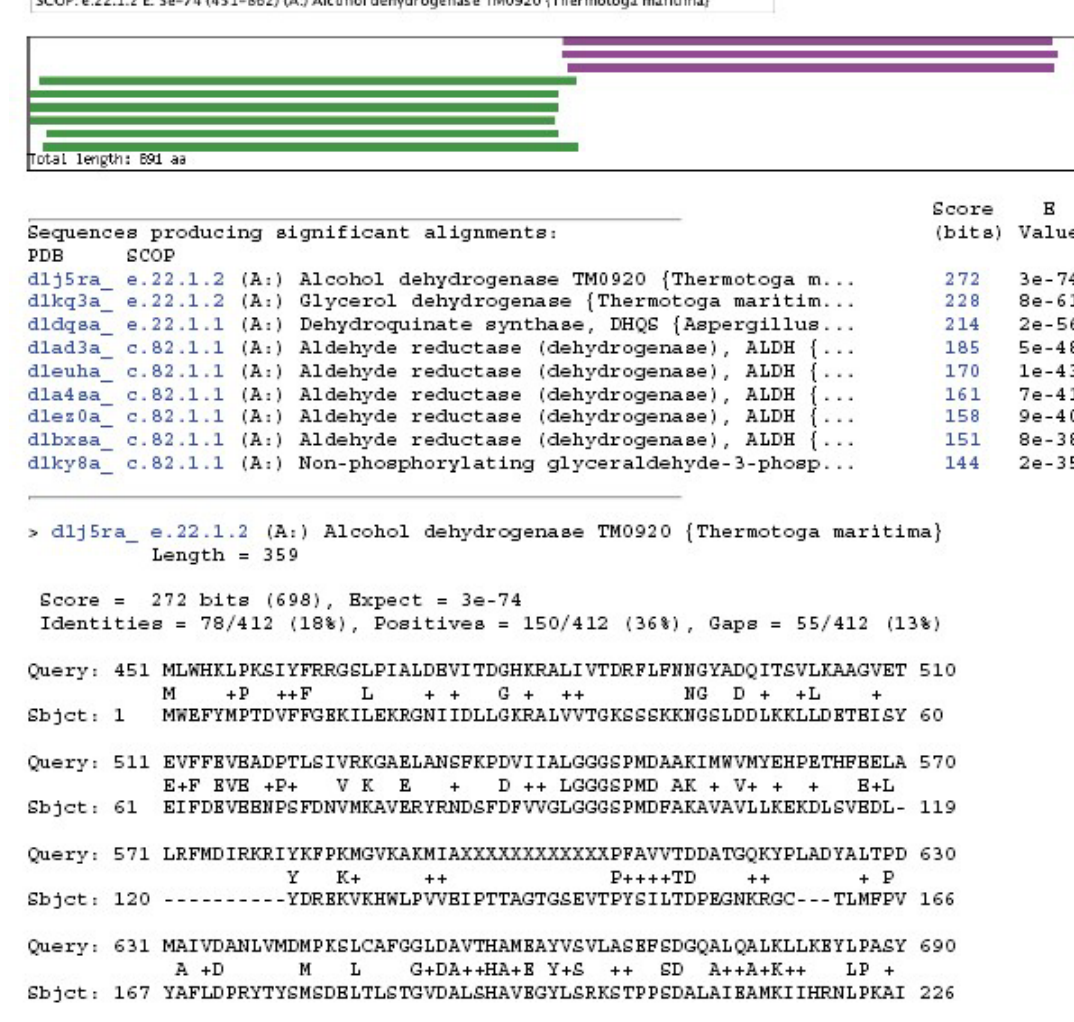
Fig. 1. The structural domain server AnDOM uses PSSMs (see text) to rapidly annotate domains of known three dimensional structure in a given sequence. Result of a search for structural domains contained in the acetaldehyde dehydrogenase sequence with the AnDom Server. The colour coding reflects the predicted three dimensional structure of the domains: Green is a mixture of α -Helix plus β -Strand (SCOP Class 3, second hit, aldehyde reductase domain), blue is α/β ( SCOP Class 4), violet corresponds to multi domain (SCOP class 5, top hit, alcohol dehydrogenase domain). The positions of the main structural domains are shown graphically on top, the middle displays the similarities to all protein structural domains found including the names of the domains, significance and references to sequence comparisons. Finally (bottom) the detailed alignments are given by the AnDOM server (as an example, only the start of the top alignment is shown in this